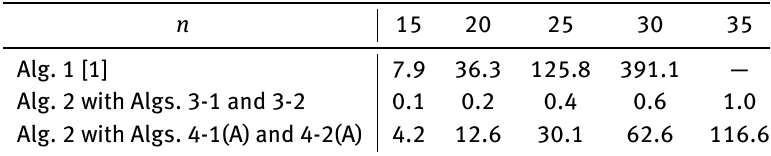
Table 2: Required time (sec) of Algorithms 1 and 2 for high symmetry T in (1) . T is generated from a = (100, 100, 100) , b = (1, 1, 1) , and c = 1 in (17) – (19) , and the size of T is n 3 × n 3 . The symbol “—” means that the algorithm did not converge to the minimum singular values of T .